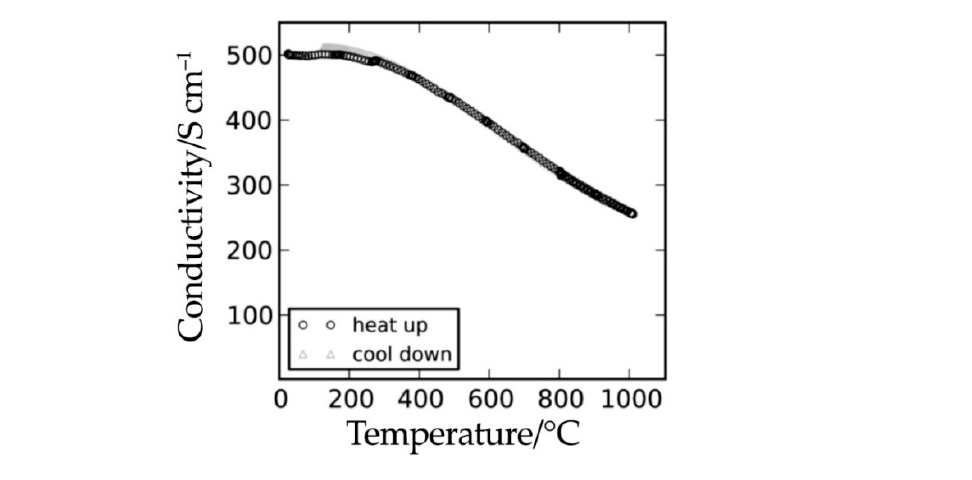
Figure 11. Conductivity of Sr 2 FeMoO 6– δ in 9%H 2 /Ar. Reproduced with permission [18]. Copyright 2010, The Electrochemical Society.